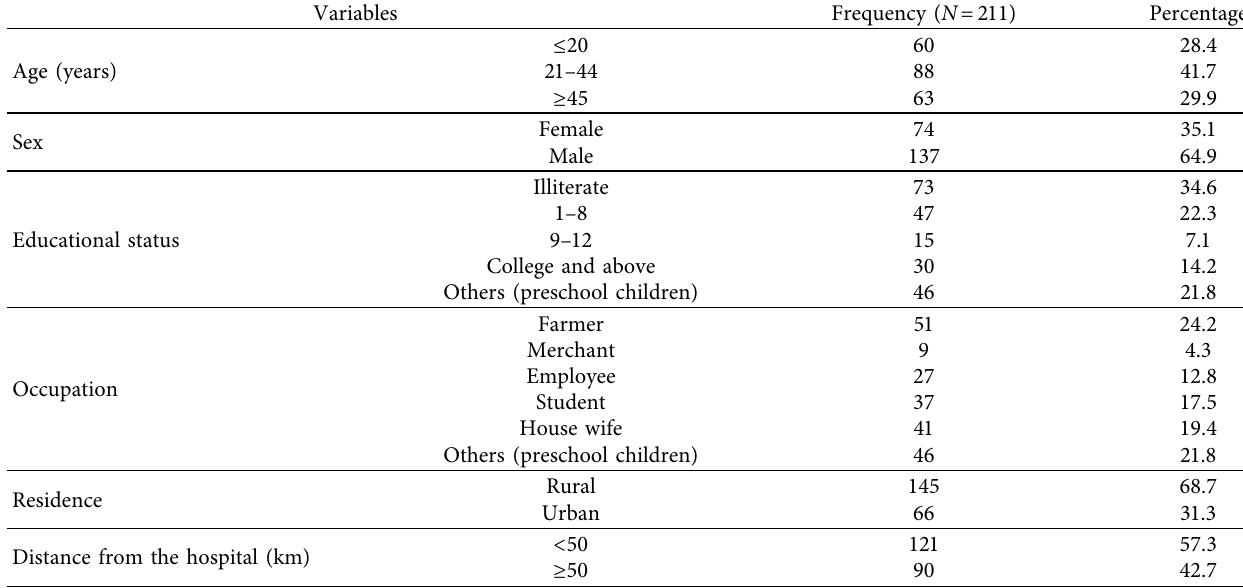
Table 1: Sociodemographic characteristics of patients managed for small bowel obstruction in Nekemte Referral Hospital from January 1,